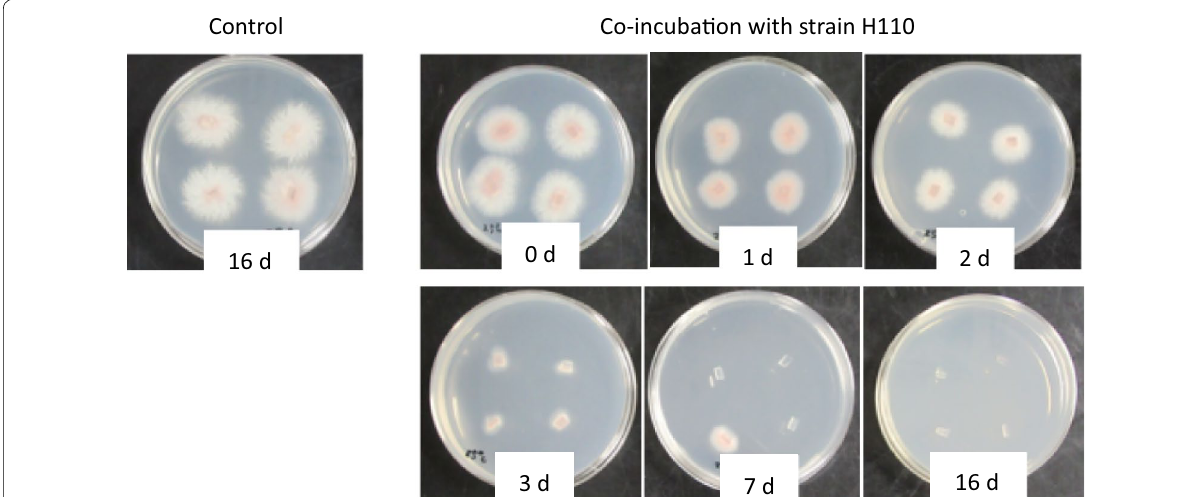
Fig. 1 Growth of mycelium of Fusarium oxysporum f. sp. spinaciae strain M2-1 from agar sections incubated alone without strain H110 (control, for 16 days) or co-incubated with strain H110 (for 0, 1, 2, 3, 7, 16 days) in the PYG broth at 25 °C. The photos were taken 2 days (agar sections co-incubated for 0, 1, 2, 3 days) or 6 days (co-incubated for 7, 16 days) after incubation of the agar sections on the fresh PDA plates at 28 °C. For the control sample, the photo was taken after 3 days incubation of the PDA plate. For each sampling day, 2 fresh PDA plates (4 agar sections per plate) were used to check growth of the pathogen from the agar